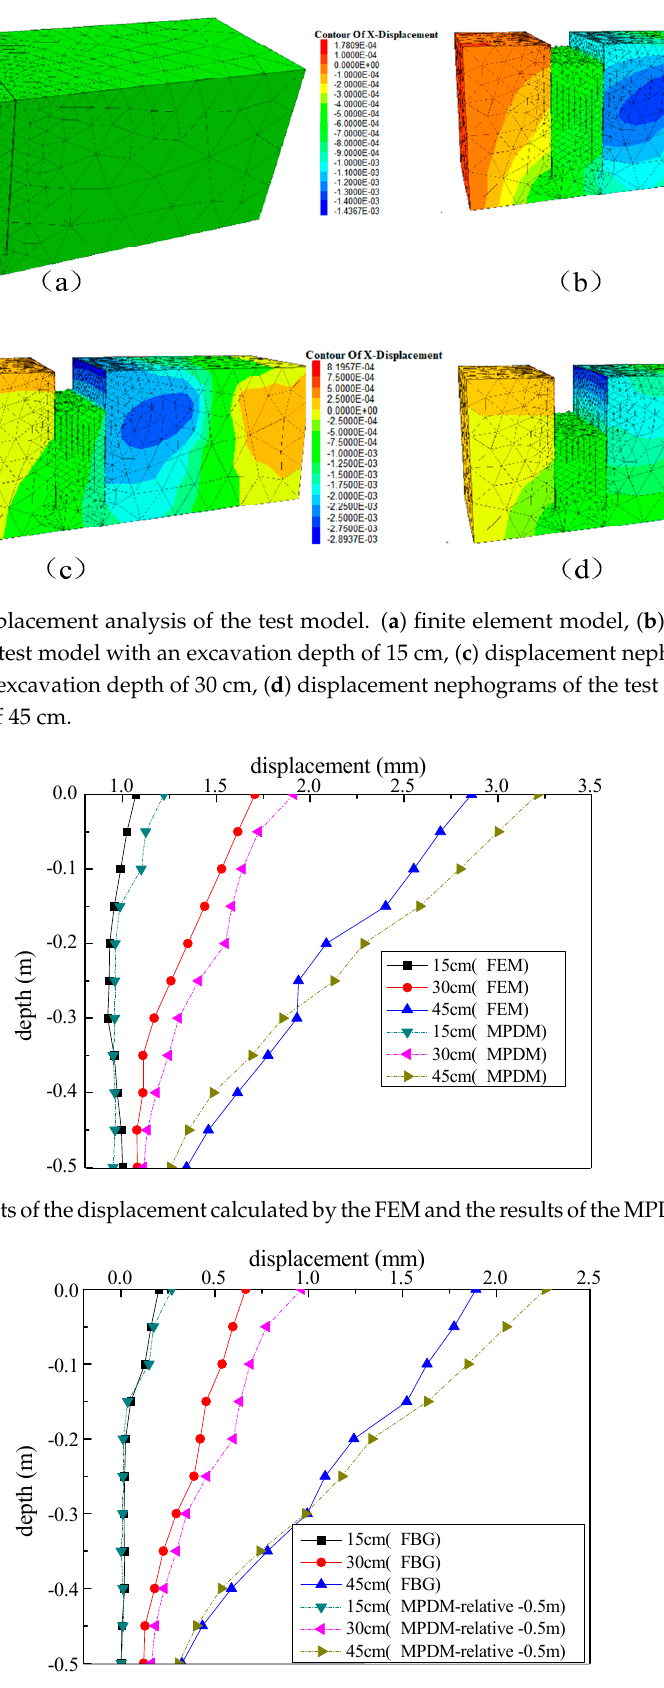
Figure 14. The result comparison of two monitoring methods.